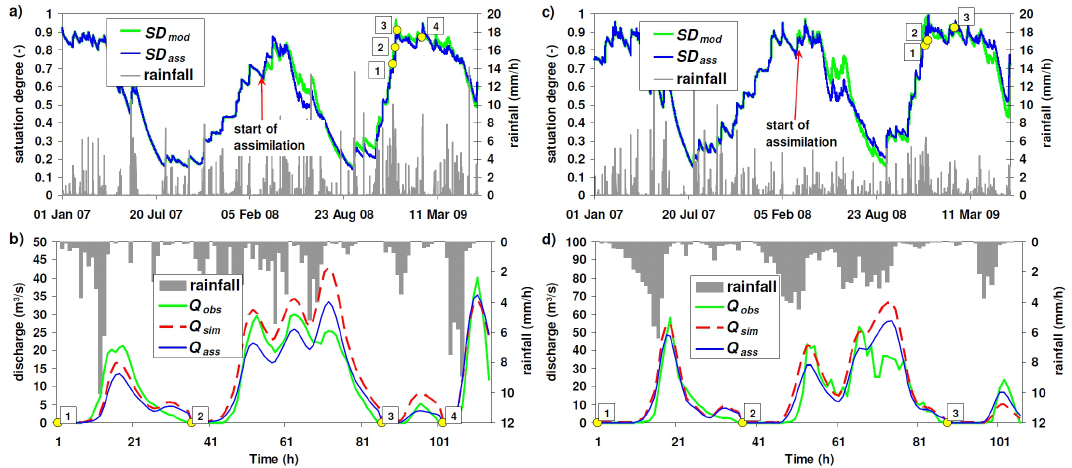
Fig. 4. – Results with and without ASCAT SWI ∗ assimilation for the NIC (a, b) and ASS (c, d) catchment in the period Janary 2007–June 2009: (a, c) observed rainfall and simulated saturation degree; (b, d) observed versus simulated discharge for the sequence of the most significant flood events occurred in the period.